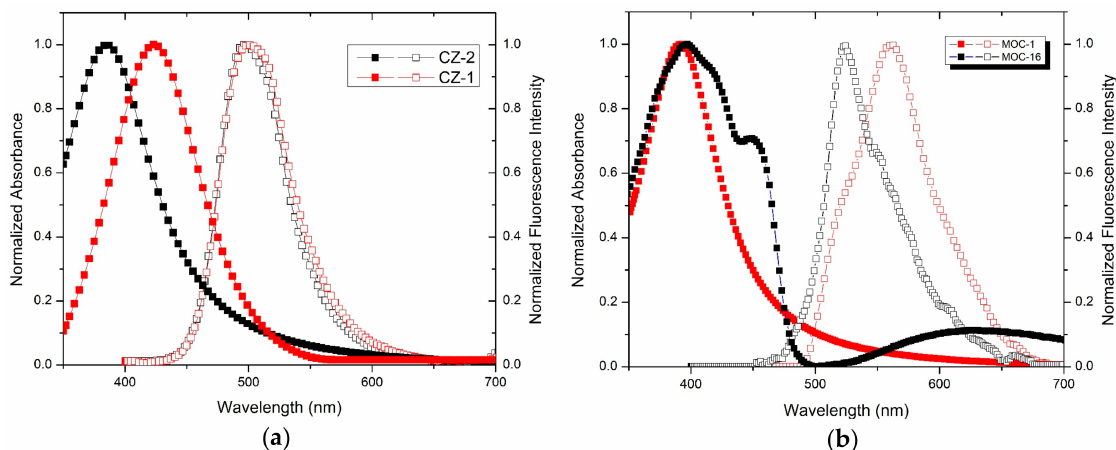
Figure 3. Absorption and fluorescence spectra of ( a ) carbazole derivatives (molecules CZ-2 and CZ-1) and ( b ) TPD derivatives (molecules MOC-1 and MOC-16) in solid state films.